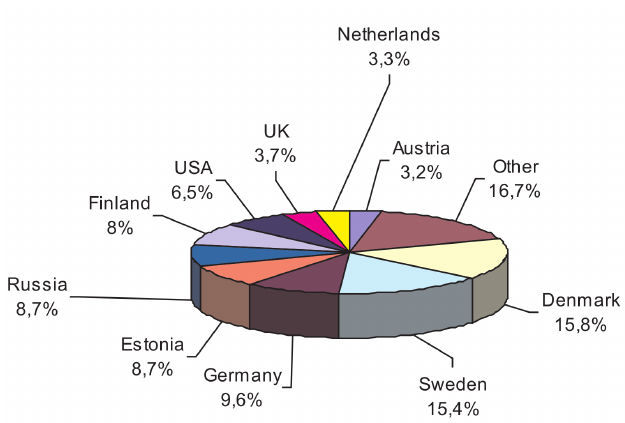
Figure 2 . Cumulative FDI in Lithuania by country